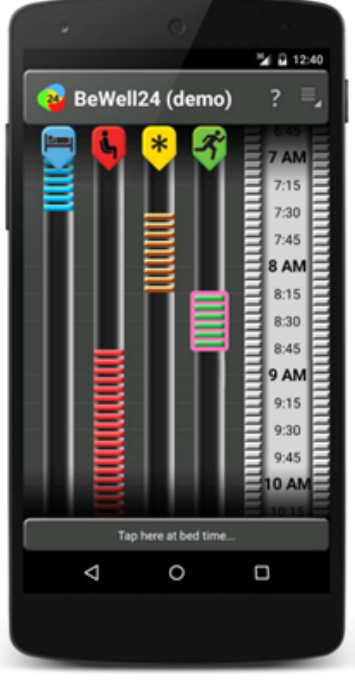
Figure 1. Self-monitoring component of the BeWell24